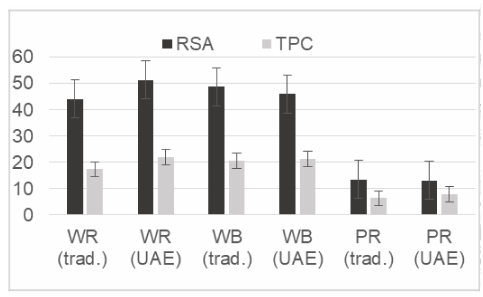
Figure 1. The Radical Scavenging Activity (RSA) and the Total Phenolic Content (TPC) obtained from ‘Violet Nori’ whole (WR), brown (BR), and parboiled (PR) rice grains by the traditional three-step extraction (trad.) and by the innovative direct Ultrasonic-Assisted Extraction